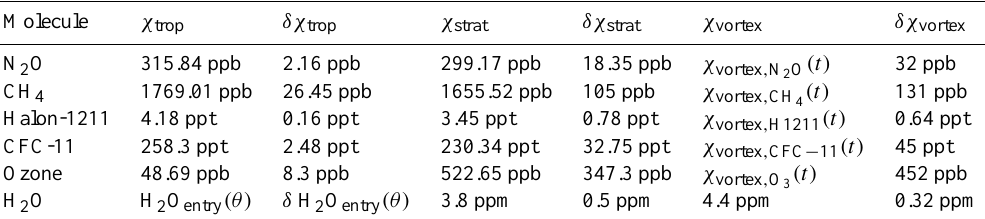
Table 2. Boundary conditions χ trop , χ strat and χ vortex of the mass balance tracers N 2 O, CH 4 , Halon-1211, CFC-11, Ozone and H 2 O. δχ denotes the estimated error of the given boundary values.